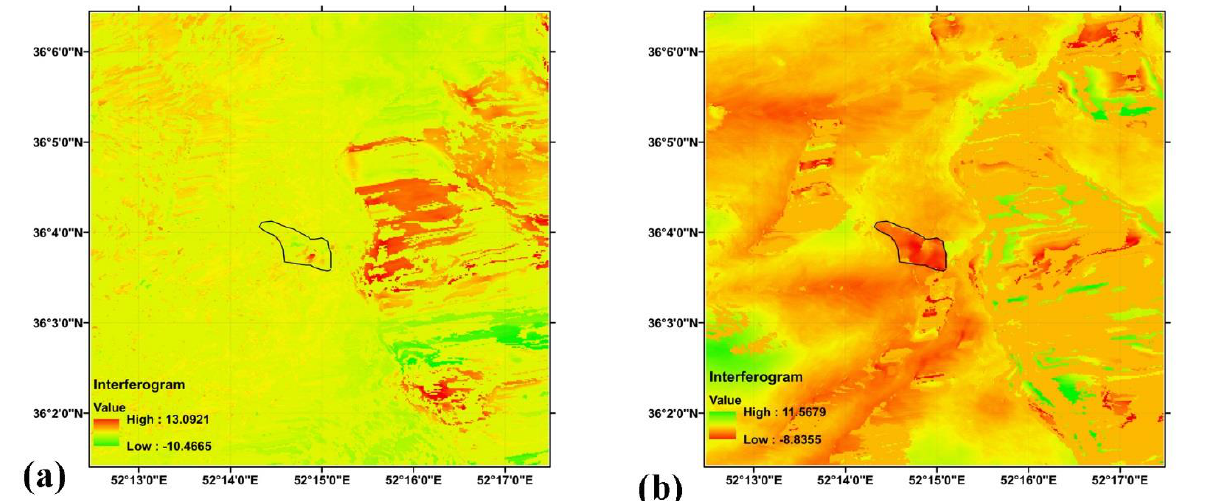
Fig 3 Two unwrapped interferograms. The interval covered by the interferograms are: (a) 2007/10/14 to 2008/03/03 and (b) 2008/06/15 to 2008/07/20. Black polyline shows the landslide boundary.